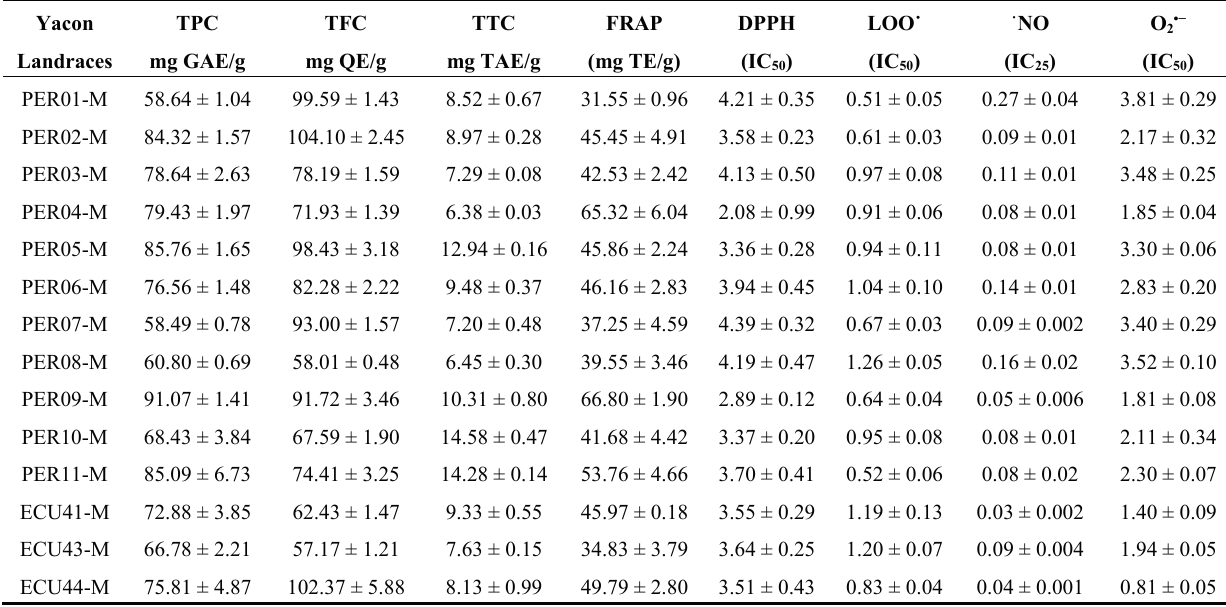
(GAE)/g = mg gallic acid equivalent per gram of dried extract; (QE)/g = mg of quercetin equivalent per gram